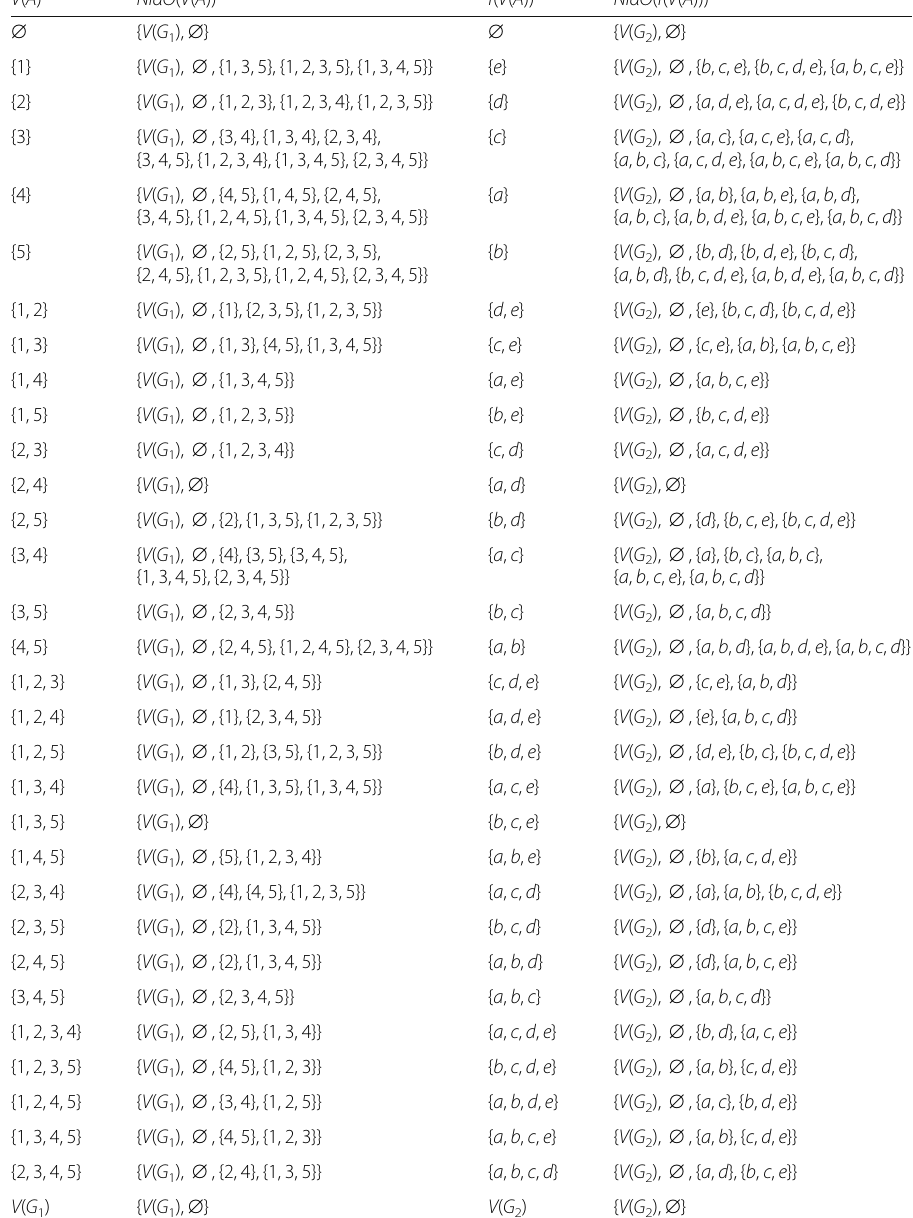
Table 2 Comparison between NI α -irresolute